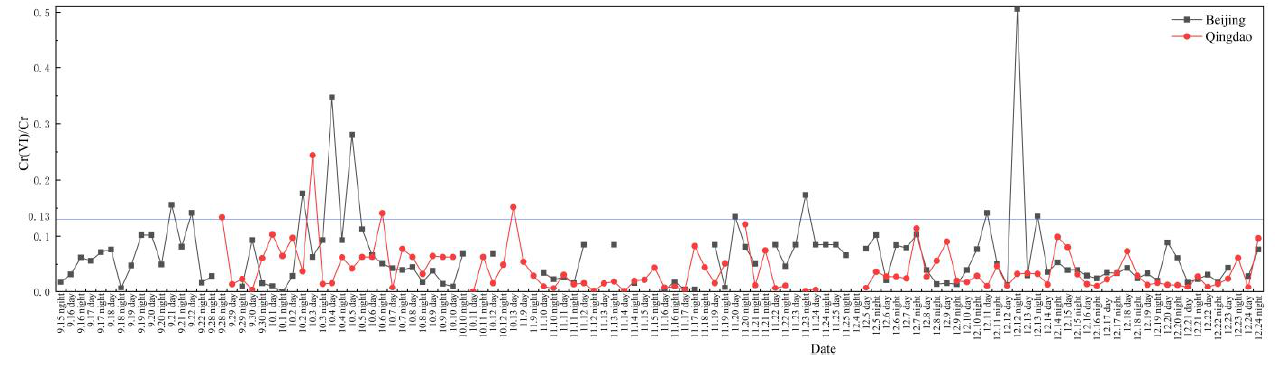
Figure 5. Frequency distribution of Cr(VI)/Cr (the purple line represents the ratio of Cr(VI) to total Cr in dust (0.13) in China).